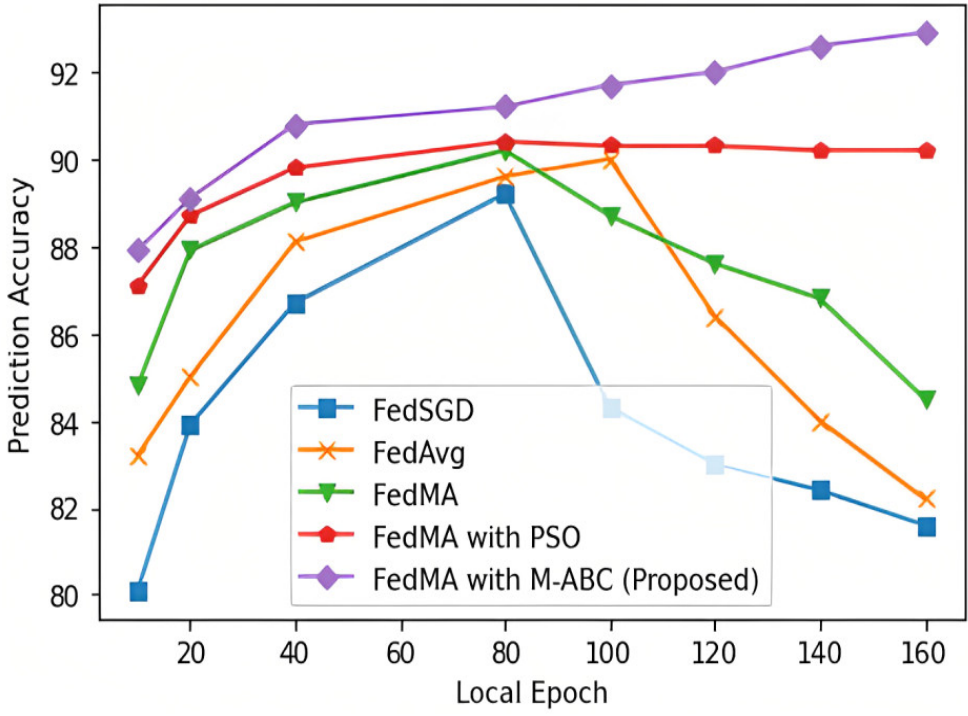
Figure 3. Effect of local epoch on accuracy.